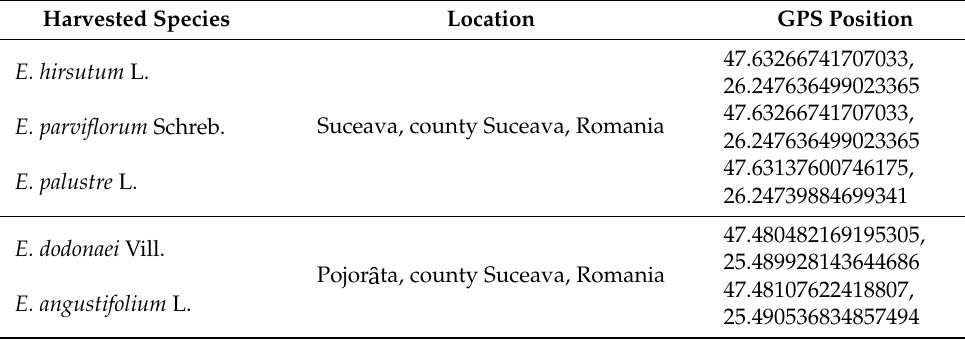
Table 1. Details regarding the harvesting period and location of endemic Epilobium species. Harvested Species Location